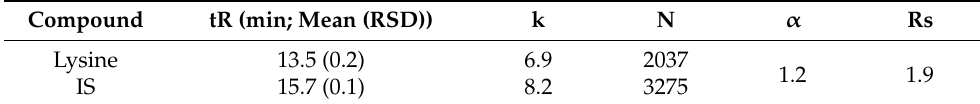
Table 1. Chromatographic information of the optimized method.